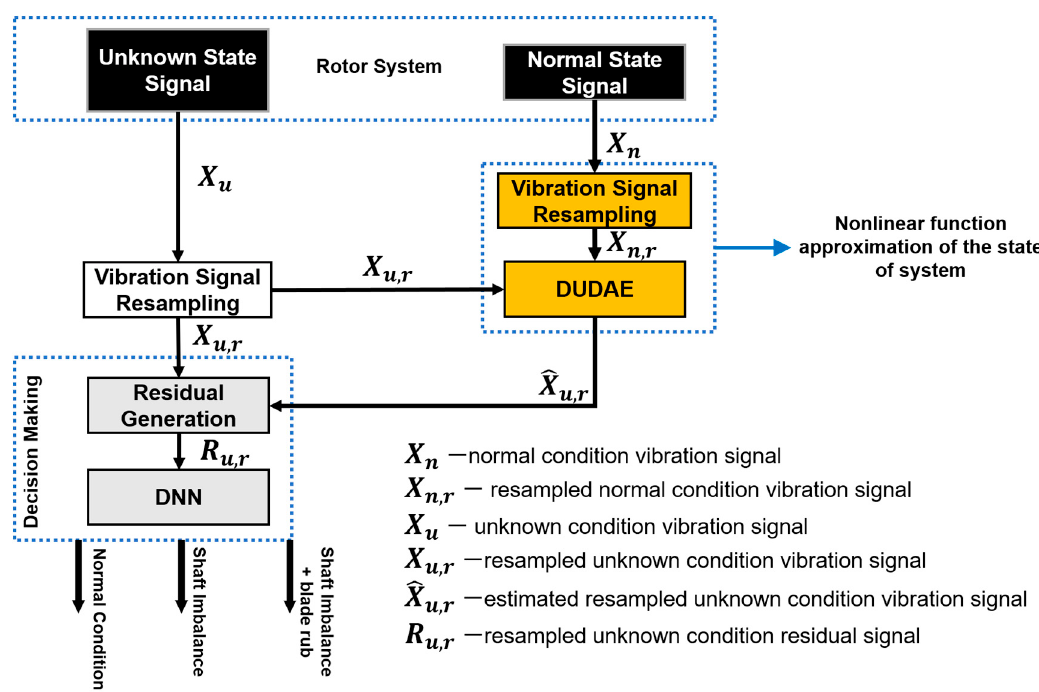
Figure 1. The proposed framework for the assessment of the health state of the rotor system.